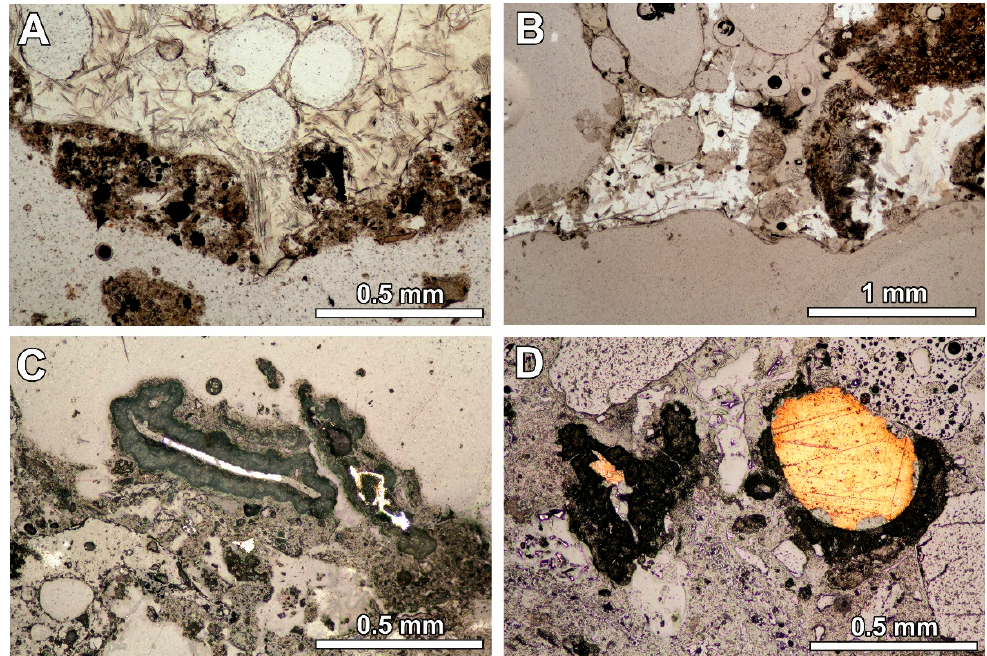
Figure 1. ( A ) Glassy melt product with elongated crystals and quench product at the margin or as a separated grain (optical microscope image, transmitting light; sample RZ4); ( B ) glassy melt product with elongated crystals with the quench phase inside (optical microscope image, transmitting light; sample RZ11); ( C ) metallic fragment in the quench product surrounded by the reaction rim (optical microscope image, reflected light; sample RZ2); ( D ) reaction rim around the metallic fragment—the rim is absent at the point of contact with the glassy fragment (optical microscope image, reflected light; sample RZ10).